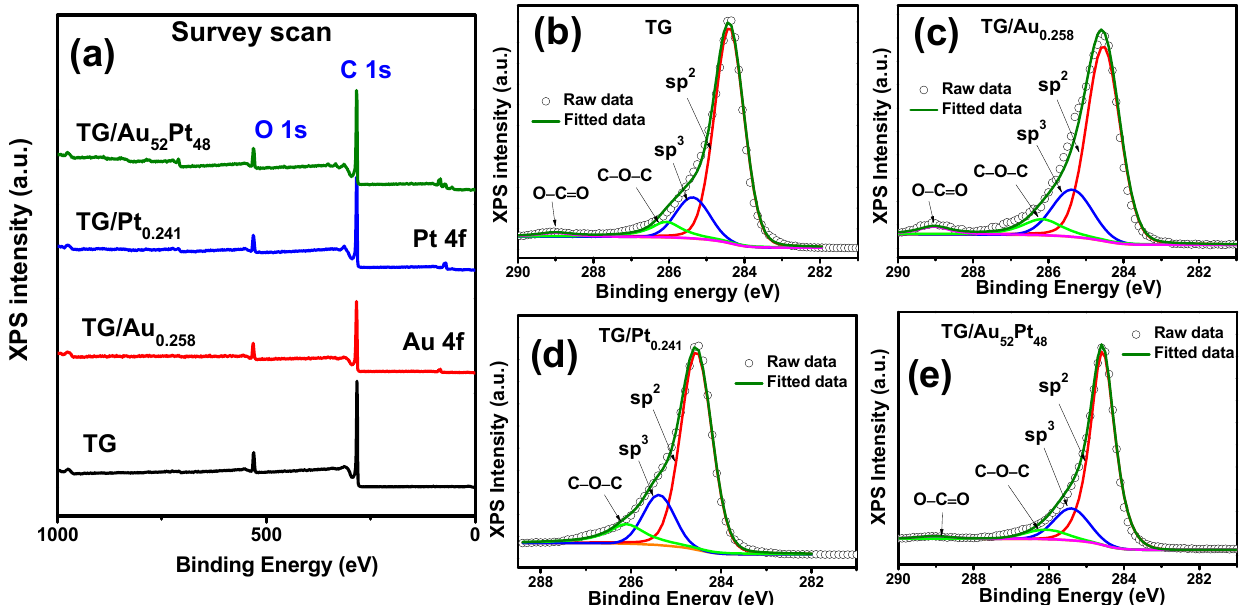
Figure 5. ( a ) XPS survey scans of four different TG-based catalysts, exhibiting the dominant C 1s and weak O 1S peaks. ( b – e ) C 1s narrow scans of the TG, TG/Au 0.258 , TG/Pt 0.241 , and TG/Au 52 Pt 48 , respectively, containing sp 2 , sp 3 bonding, and small quantity of oxygen-attached carbon functional group.